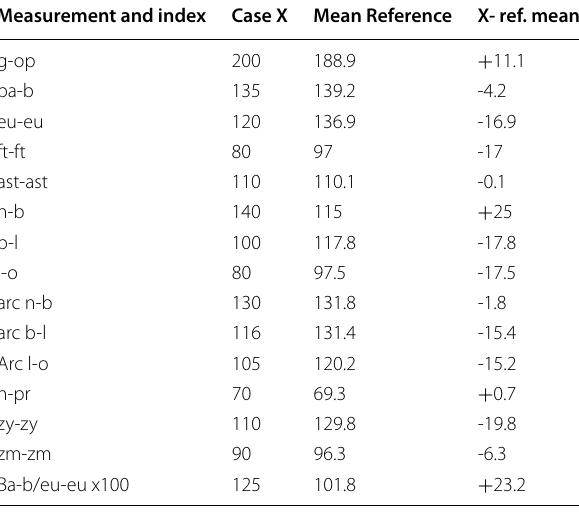
The measurements and index of the case X. The difference between the case and reference(X-ref)